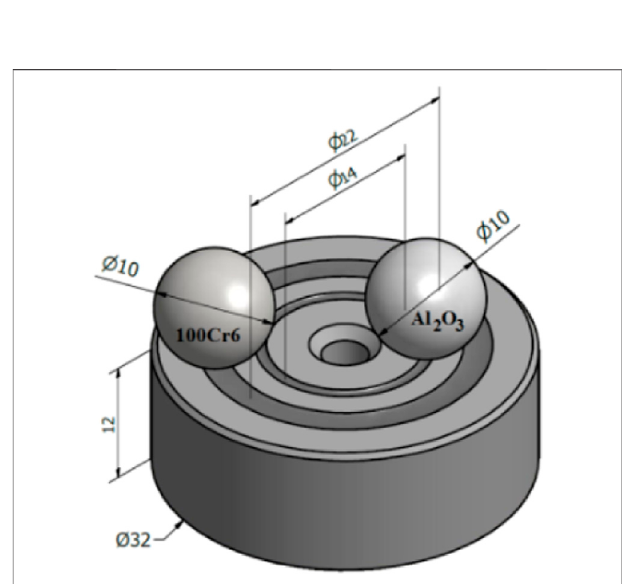
FIGURE 3 | An example of a sample used during the pin-on-disc tests and two types of A 2 O 3 or 100Cr6 pins as counterbodies.